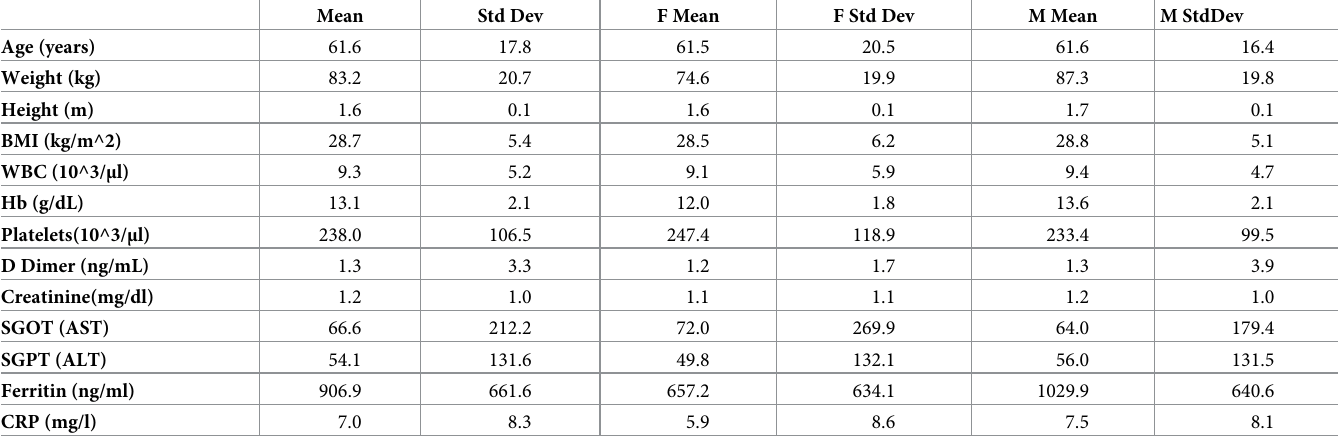
Table 1. Descriptive statistics of the continuous variables in the COVID-19